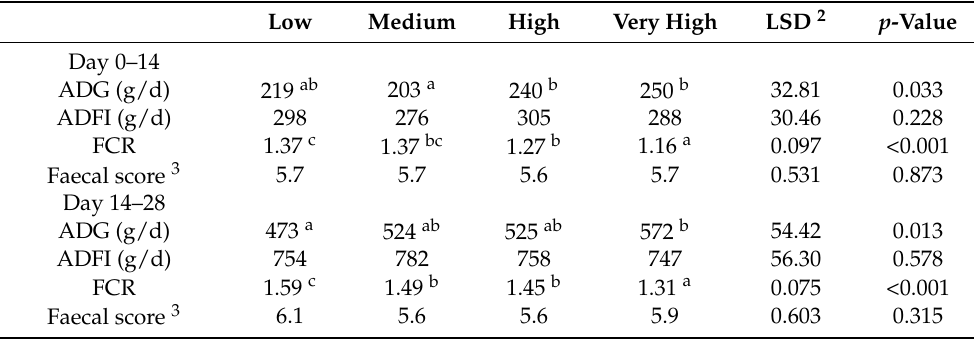
Table 5. The effect of standardised ileal digestible (SID) lysine concentration on post-weaning growth performance 1 . Low Medium High Very High LSD 2 p